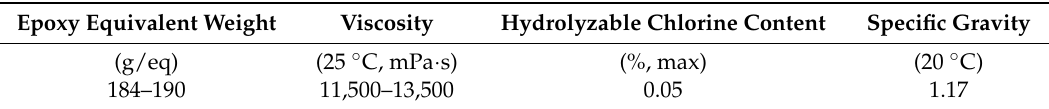
Table 1. Physical properties of the bisphenol A-type epoxy resin YD-128.